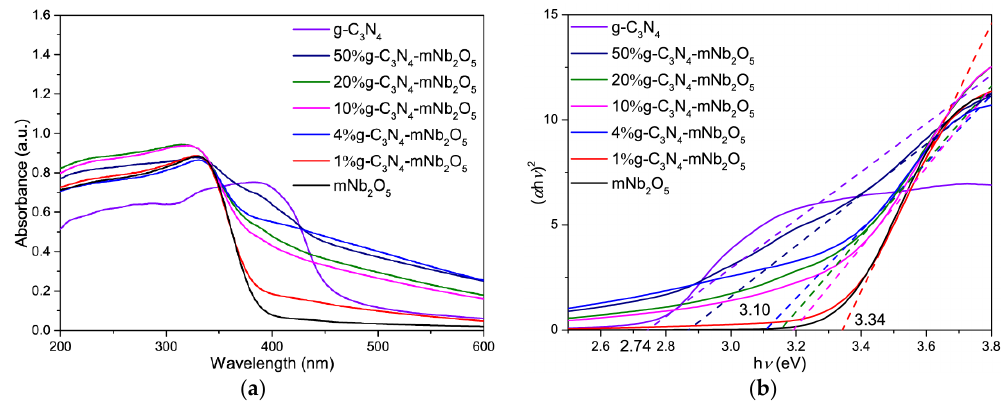
Figure 5. ( a ) UV-vis diffuse reflectance spectra; and ( b ) plots of the ( α h υ ) 2 vs. (h υ ) of mNb 2 O 5 , g-C 3 N 4 , and g-C 3 N 4 -mNb 2 O 5 composites with different content of g-C 3 N 4 .